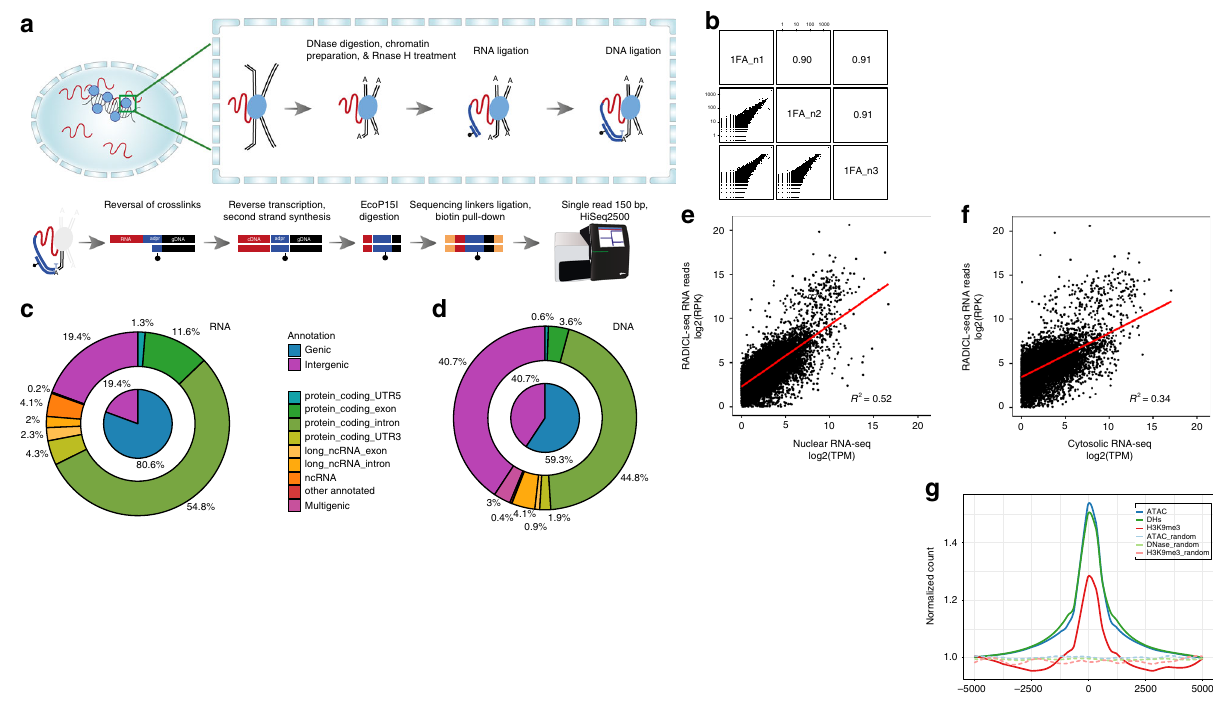
Fig. 1 RADICL-seq method for the identi fi cation of RNA – chromatin interactions. a Schematic representation of the RADICL-seq protocol. Top: sequence of enzymatic reactions occurring in fi xed nuclei after partial lysis of the nuclear membrane. The adduct formed by genomic DNA (black), RNA (red), and proteins (blue circles) is subjected to controlled DNase I digestion and chromatin preparation. After RNase H digestion, an adapter (dark blue) containing an internally biotinylated residue (black dot) bridges the RNA and DNA molecules that lie in close proximity. Bottom: sequence of enzymatic reactions performed in solution. After reversal of crosslinks, the RNA – DNA chimera is converted into a fully double-stranded DNA (dsDNA) molecule and digested by the Eco P15I enzyme to a designated length (adpr, adapter). After ligation of the sequencing linkers (yellow) and biotin pull-down, the library is PCR ampli fi ed and high-throughput sequenced. b Reproducibility of the RNA – DNA interaction frequencies across replicates, assessed by counting the occurrences of genic transcripts and 25-kb genomic bin pairs. c RNA and d DNA tag origins. The inner pie charts represent a broader classi fi cation into intergenic and genic (annotated genes), while the outer circles show a fi ner classi fi cation of the genic portion. e , f Comparison between ( e ) nuclear and ( f ) cytosolic RNA-seq tag counts and RADICL-seq genic transcript counts. The former are normalized to tags per million (TPM), while the latter are normalized to reads per kilobase (RPK). The linear regression lines are shown in red. g Density of the normalized counts of DNA reads detected by RADICL-seq around ATAC-seq (blue), DHS-seq (green), and H3K9me3 ChIP-seq (red) peaks; dashed lines represent the density pro fi les of aggregated signal from random genomic reads equal in number and size to the real protein-coding genes, suggesting a multi-layered regulation for